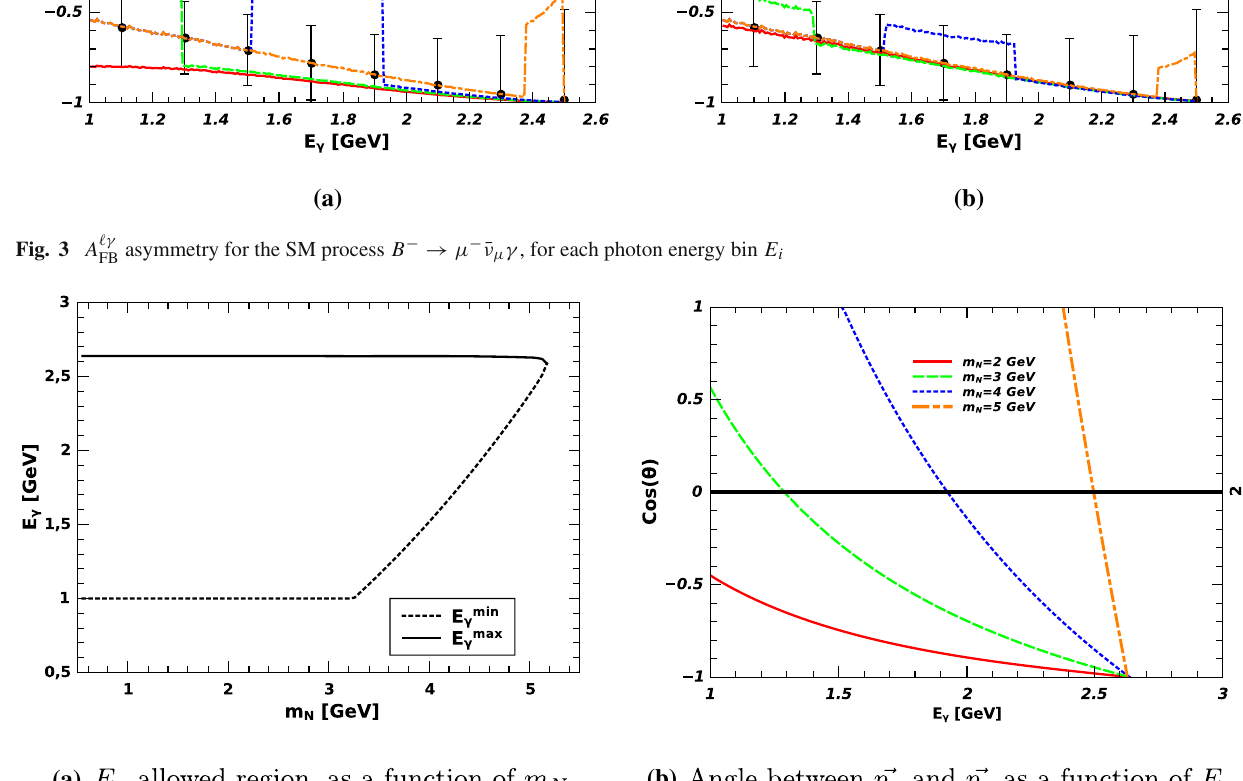
Fig. 4 B − → μ − νγ kinematics in the B rest frame treatment in the calculation [73], and to the minimal allowed energy E min